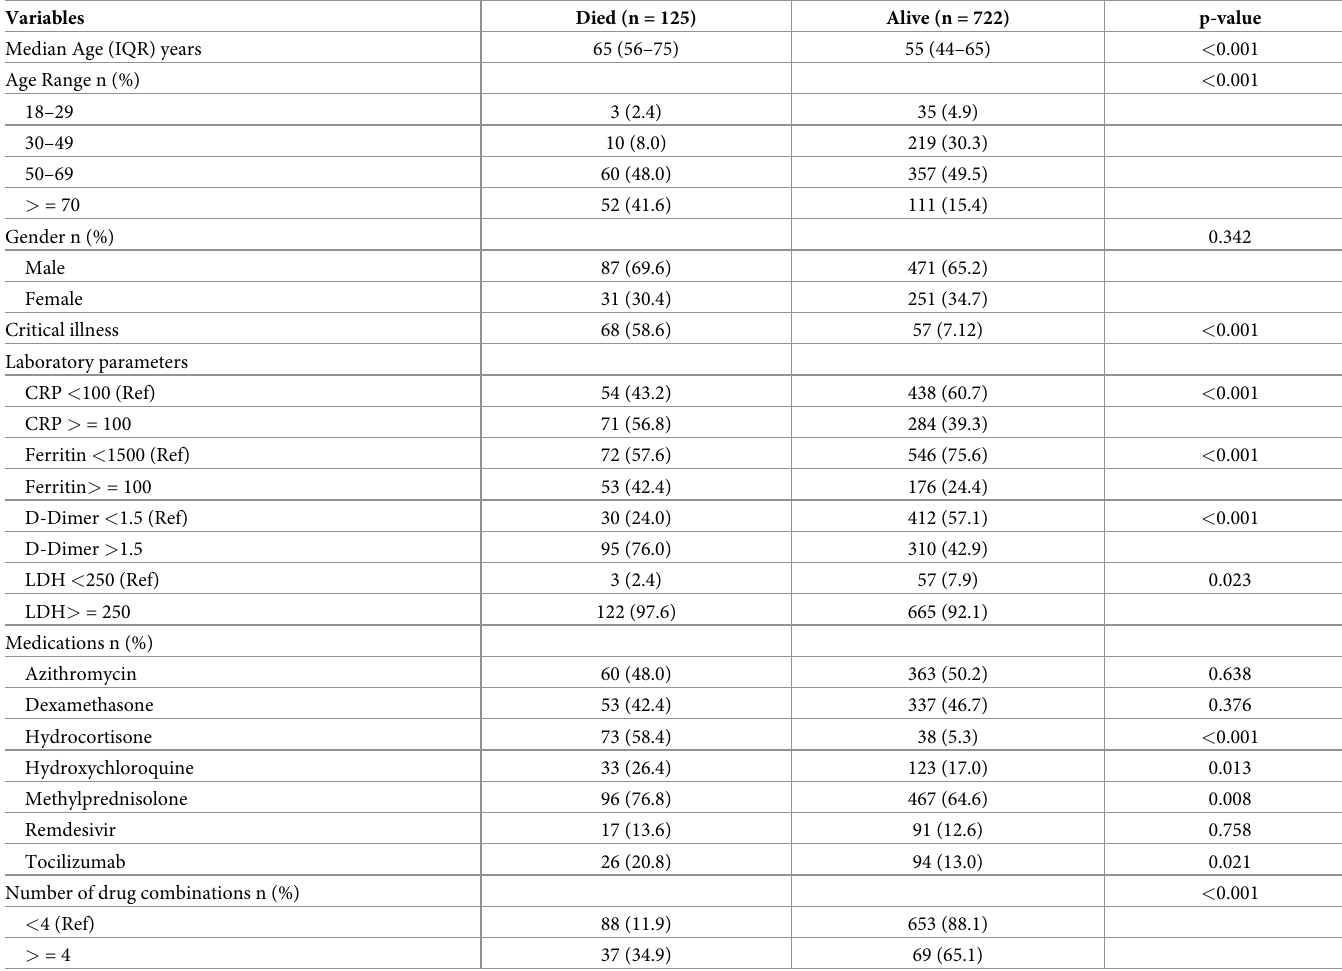
Table 1. Comparison of COVID-19 patients who died and who